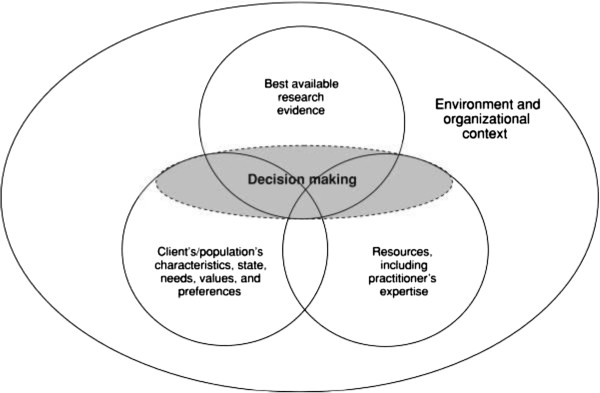
Evidence based clinical decision making Venn diagram2.